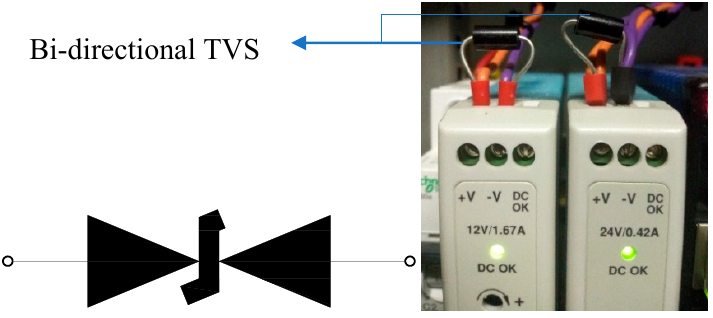
Figure 2. 1.5KE30CA bi-directional transient voltage suppressor.